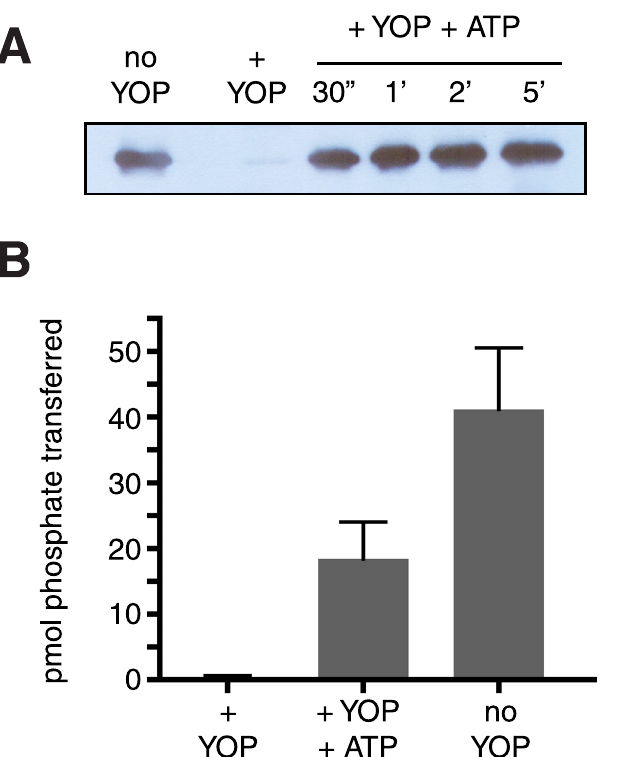
Fig 4. Regulation of MbAbl2 by autophosphorylation. (A) Purified MbAbl2 (200 μ l of 825 nM) was incubated with immobilized GST-YOP tyrosine phosphatase (200 μ l) for 45 minutes at room temperature, or left untreated (no YOP). Following removal of GST-YOP by centrifugation, autophosphorylation was initiated by the addition of ATP (0.5 mM) and MgCl 2 (20 mM). After various reaction times (at room temperature), aliquots were removed and immediately quenched by addition of Laemmli sample buffer and boiling. The samples were analyzed by SDS-PAGE and anti-pTyr Western blotting; equal amounts of MbAbl2 (14 pmol) were analyzed in each lane. (B) YOP treatment and autophosphorylation were carried out as in panel (A). After 30 min. of autophosphorylation, MbAbl2 activity was measured using the phosphocellulose paper binding assay with Abl peptide (740 μ M). Kinase reactions proceeded for 10 minutes at 30°C. Error bars show standard